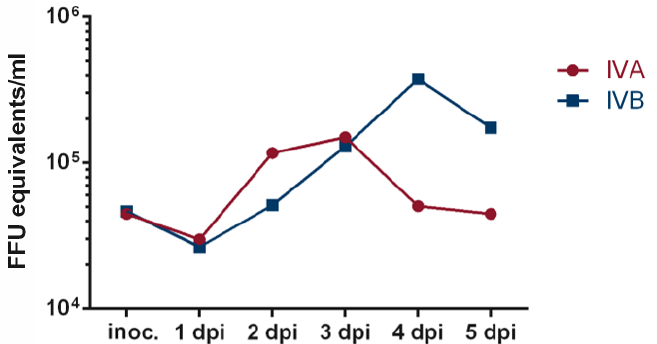
Figure 2. Fluenz ® Tetra infection of Vero-E6 cells. A CCU was coated with laminin in the CliniMACS Prodigy ® and subsequently seeded with 4.5 × 10 6 freshly thawed Vero-E6 cells. After a 48-h incubation period at 39 ◦ C, the culture was infected with Fluenz ® Tetra at a dose of 10 6 FFU per strain. Media was changed and a sample taken after 4 h at 35 ◦ C (corresponding to 33 ◦ C in the CCU) followed by a daily media change and sample collection. Purified RNA from the samples was analyzed by Influenza A (IVA) and Influenza B (IVB)-specific reverse transcriptase qPCR. Purified RNA from Fluenz ® Tetra was assigned the FFUs contained in the volume of Fluenz ® Tetra the RNA was extracted from and used as a standard. Shown are FFU equivalents/mL for individual samples for IVA and IVB,